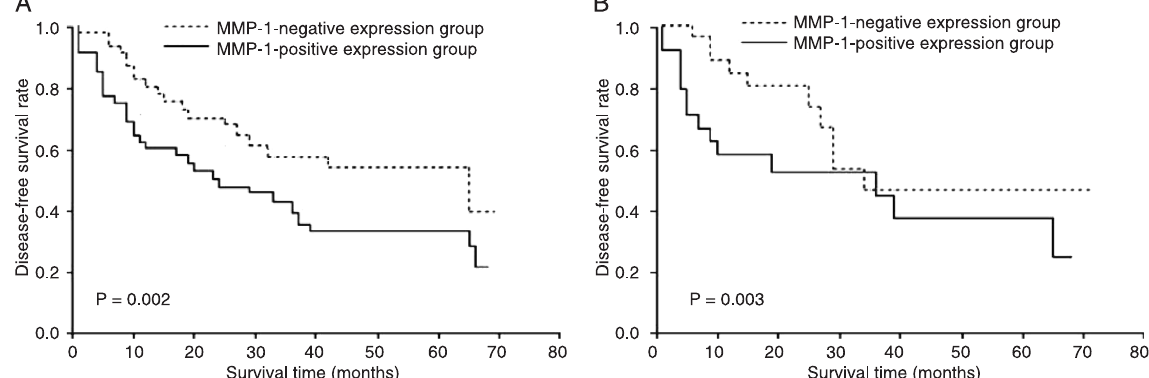
Figure 2. Survival curves according to matrix metalloprotease-1 (MMP-1) and protease-activated receptor-1 (PAR-1) expression. A , Disease-free survival curves according to MMP-1 expression for all patients plotted by the Kaplan-Meier method. B , Disease- free survival curves according to PAR-1 expression for all patients plotted by the Kaplan-Meier method. Differences between the two groups were evaluated by the log-rank test.